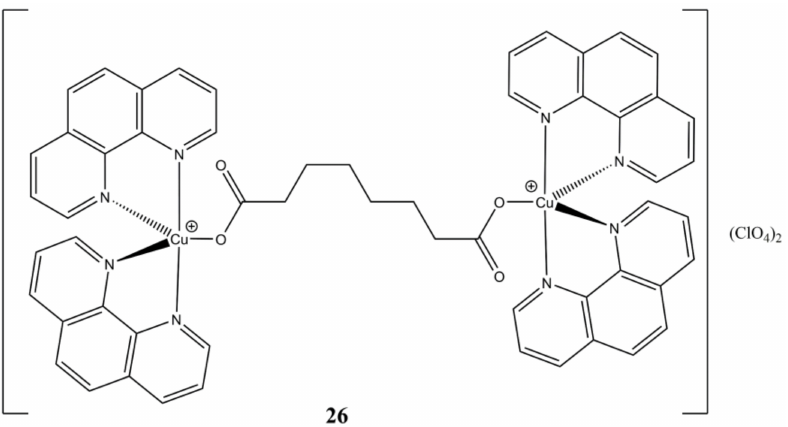
Figure 26. Structure of the [Cu 2 ( µ -oda)(phen) 4 ](ClO 4 ) 2 complex. This complex shows time and concentration dependent (from low micromolar to nanomolar at 24 and 96 h of treatment, respectively) cytotoxic activity towards colorectal HT29, SW480 and SW620 cancer cells. In vivo drug tolerability studies on G. Melonella larvae shows that the complex is better tolerated than cisplatin in the 200–1000 µ g/mL concentration range. The reported compound shows good ct-DNA affinity, self-activating DNA cleavage ability in presence of oxygen, along with artificial SOD activity and cellular ROS induction ability. The authors combined these experimental evidence and proposed a model of DNA cleavage based on the formation of reduced [Cu(phen) 2 ] + complex and a π carboxylate radical, which can oxidatively damage DNA in multiple ways. For instance, the carboxylate radical and/or its alkyl product of decarboxylation might abstract a hydrogen from the DNA phosphodiester backbone, while the [Cu(phen) 2 ] + complex might induce DNA breaks through aerobic-generated oxo and hydroxo complexes